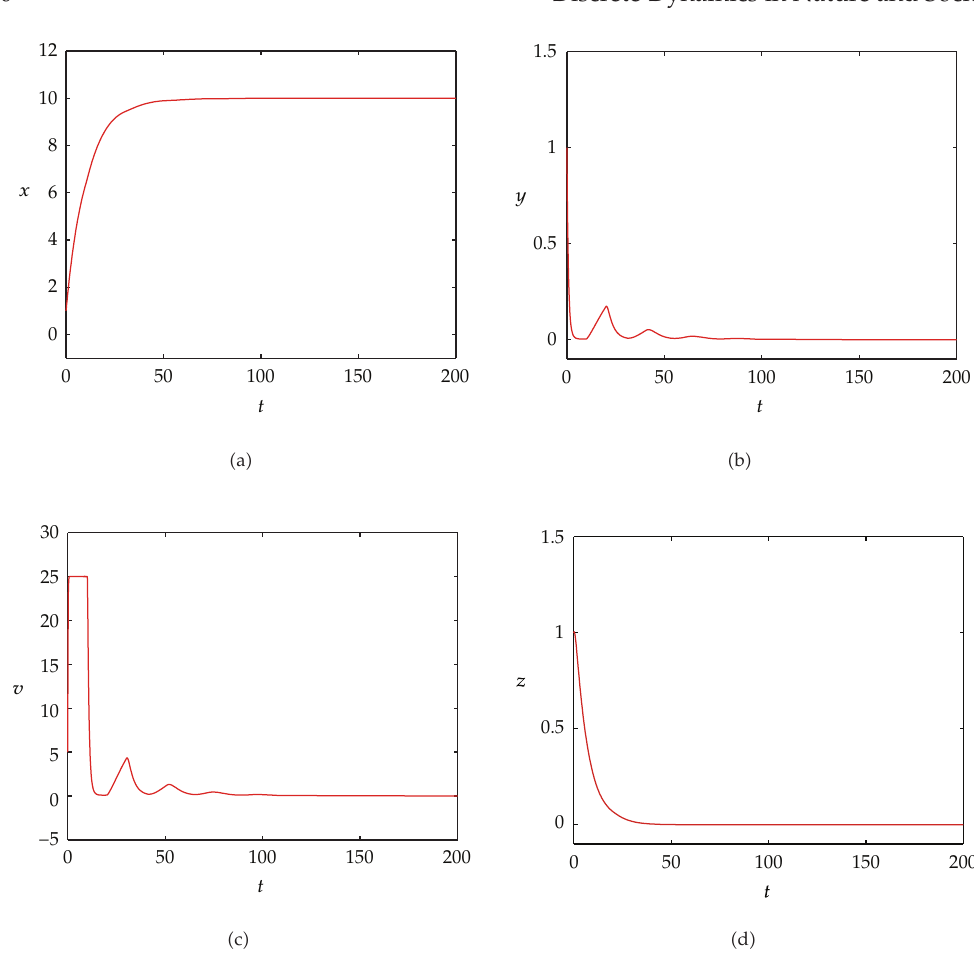
Figure 1: The infection-free equilibrium E 0 of system (cid:2) 1.2 (cid:3) is globally asymptotically stable. Here τ 1 (cid:7) 10, τ 2 (cid:7) 10, and the initial value is (cid:2) x 0 (cid:7) 1 ,y 0 (cid:7) 1 ,v 0 (cid:7) 5 ,z 0 (cid:7) 1 (cid:3)